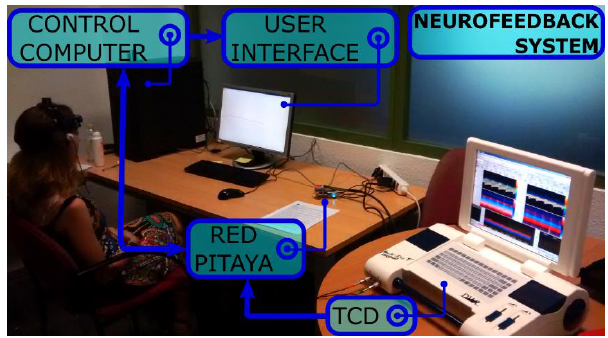
Figure 2. Different parts of the developed TCD-based neurofeedback system can be observed in the figure. The TCD ultrasound device registers the cerebral blood flow velocity (CBFV) signals from the